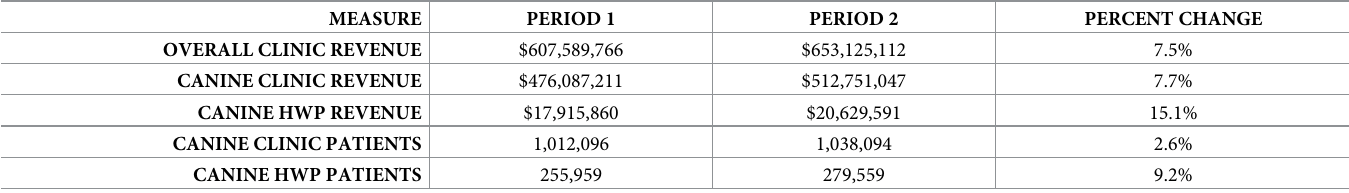
Table 3. Comparison of practice revenue, period 1 vs period 2, New PH 12 Users.